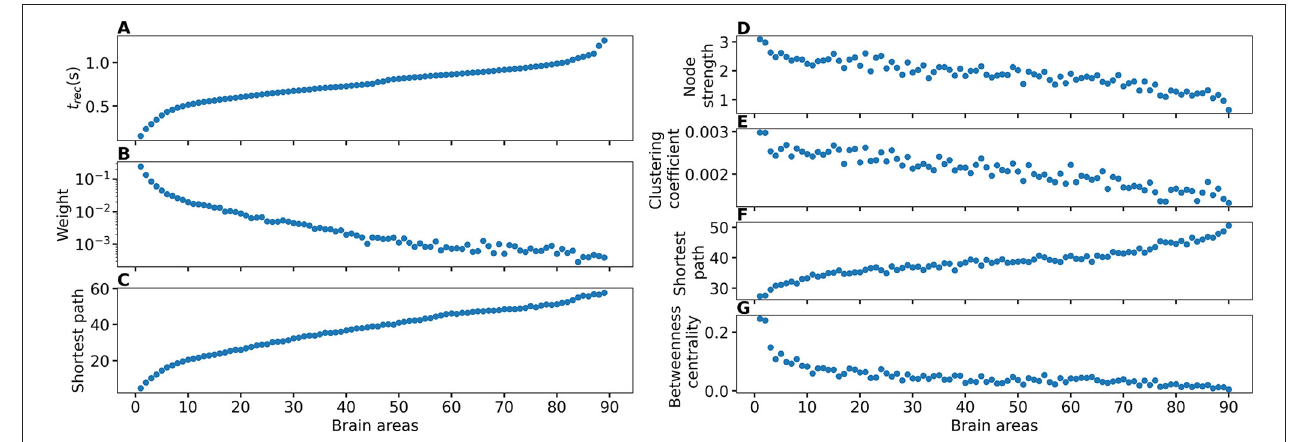
FIGURE 6 | (A) Recruitment times reported in descending order: Brain area 1 is the brain area that is recruited first and brain area 90 is the last recruited brain area. (B) Connection weights between the recruited brain area and the EZ, ordered according to their recruitment time, thus following the indexing of (A) . (C) Shortest path between the recruited area and the EZ, ordered according to their recruitment time. (D) Connection weights between the recruited brain area and all the nodes except EZ, ordered according to their recruitment time. (E) Clustering coefficient between the recruited brain area and all the nodes except EZ, ordered according to their recruitment time. (F) Shortest path between the recruited area and all the other nodes except EZ, ordered according to their recruitment time. (G) Betweenness centrality between the recruited brain area and all the nodes except EZ, ordered according to their recruitment time. The excitability η ( k ) gen , according to Figure 3B for each subject separately. Data are averaged over all subjects and all the stimulated areas. Parameters: N pop threshold ¯ σ 1, I S 10, t I 0.4 s as in Figure 3 . = = =